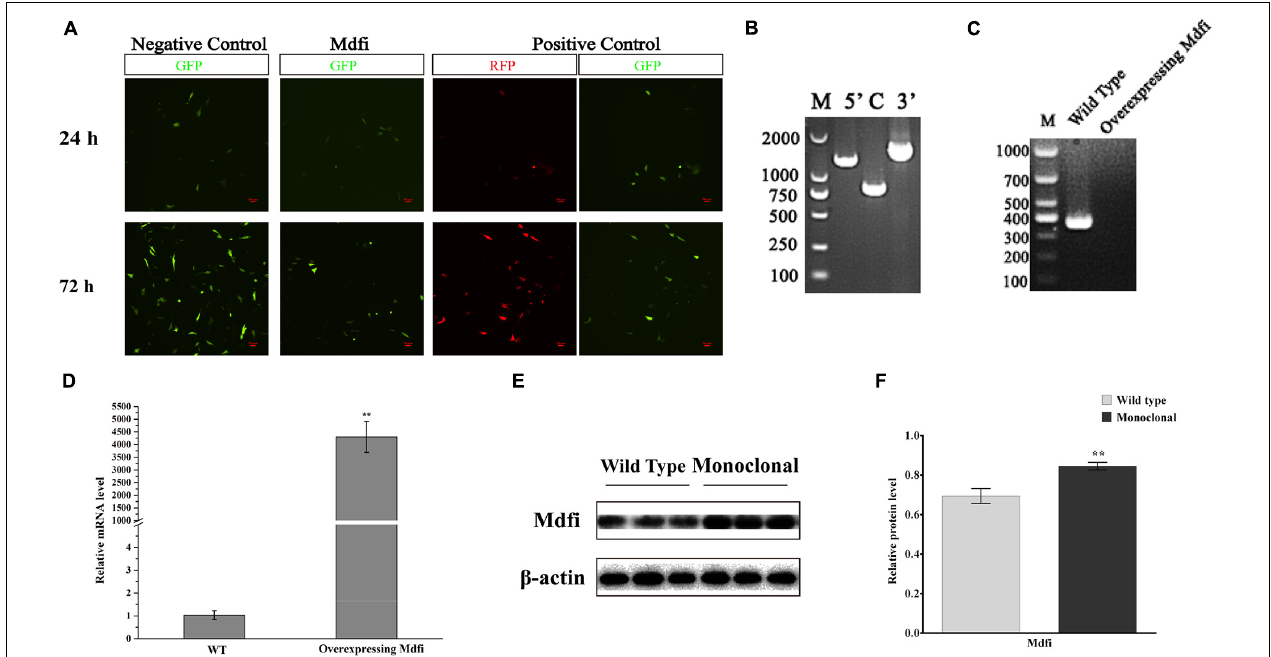
FIGURE 2 | Construction of a Mdfi-overexpressing C2C12 cell line. (A) Inverted fluorescence microscopy was used to investigate the expression of GFP and RFP protein in the C2C12 cell after puromycin screening for 24 and 72 h after transfected with Rosa26 + Donor, Rosa26 + Donor-Mdfi, and Rosa26+ Donor-RFP, respectively. (B) The homologous recombination status of left and right homologous arms and the insertion of the Mdfi gene in the monoclonal clone was confirmed. (C) Single or double allele insertion of Mdfi in monoclonal clone was confirmed through PCR amplification. (D) qPCR measured the mRNA level of Mdfi. (E) Western blot measured the protein level of Mdfi. (F) The relative protein levels obtained through Western blot band gray scanning analysis. *** p < 0.001. The results are presented as Mean ± SEM of three replicates for each